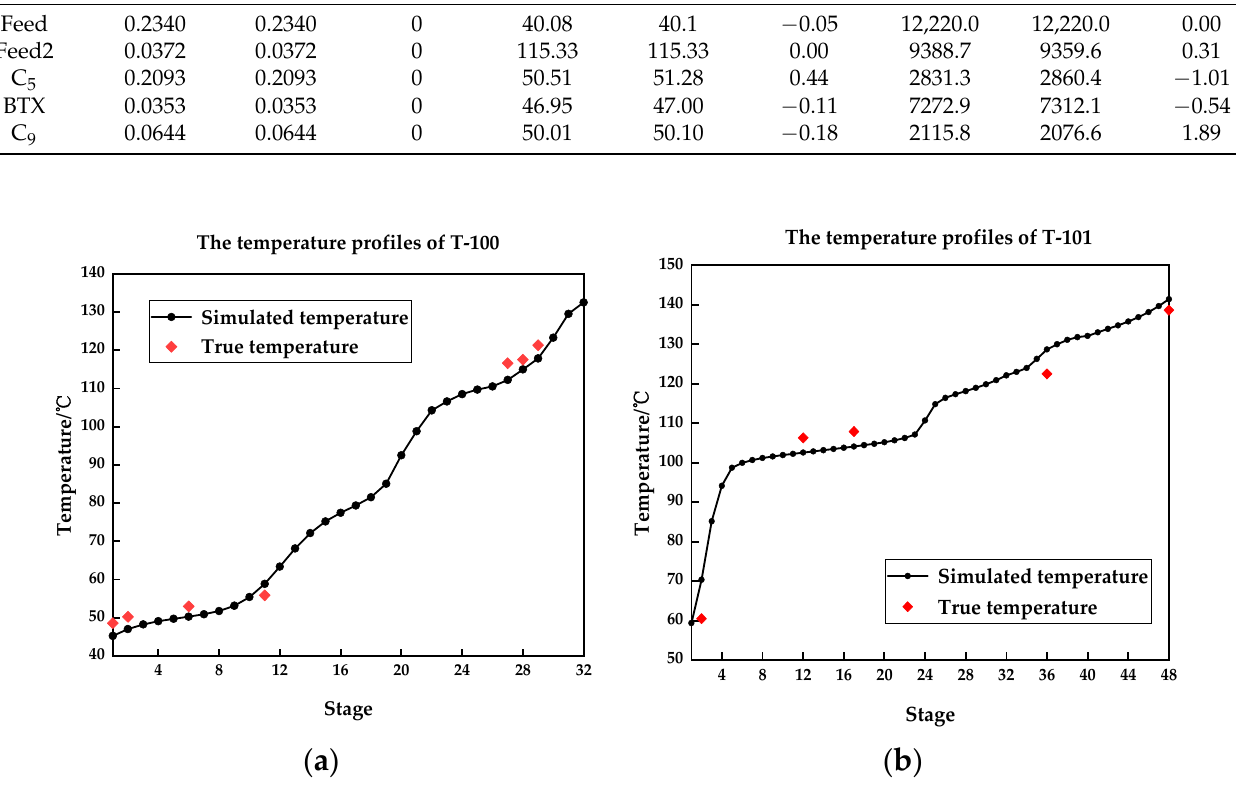
Figure 8. The temperature profiles of T-100 and T-101: ( a ) temperature profiles of T-100; ( b ) temperature profiles of T-101.